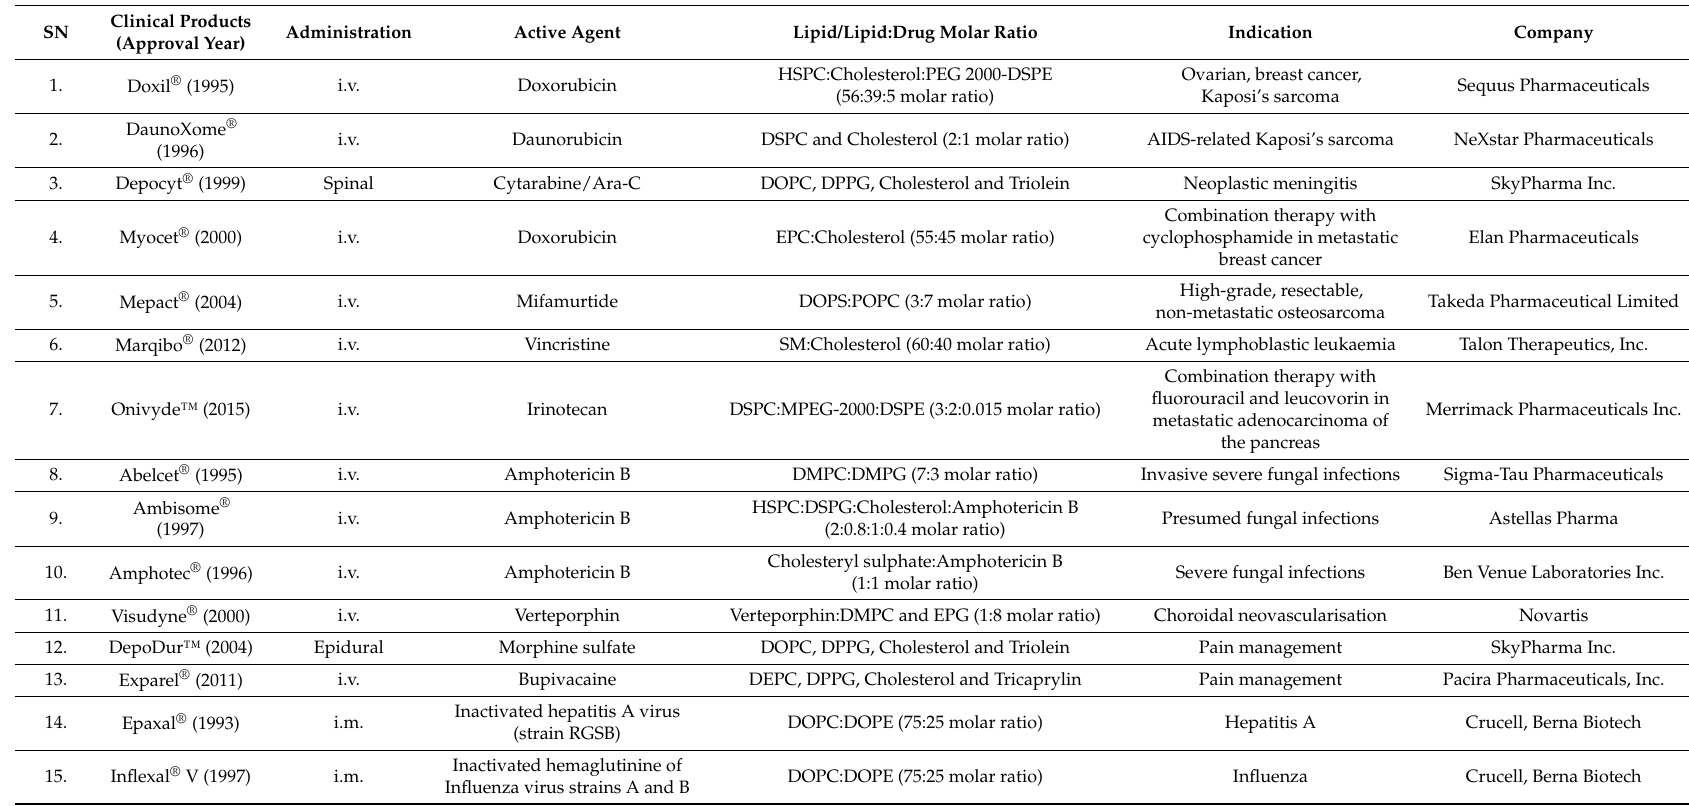
Table 1. Clinically used liposome-based